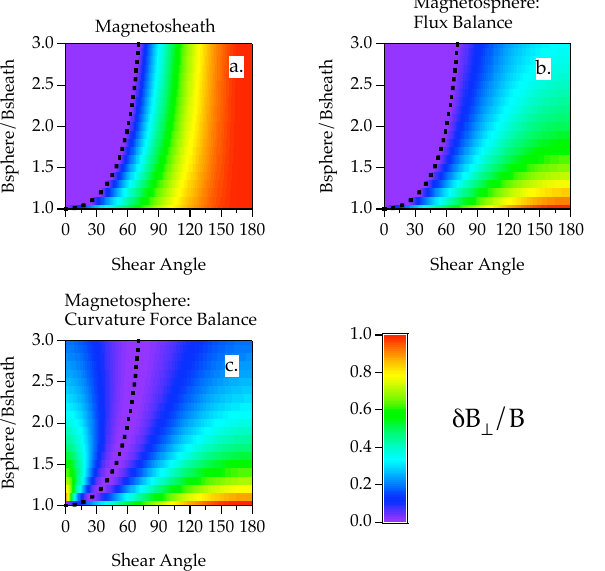
Fig. 3. As in Fig. 2, but for ratios of the magnetic field perturbations normal to the nominal magnetopause to the ambient magnetic field